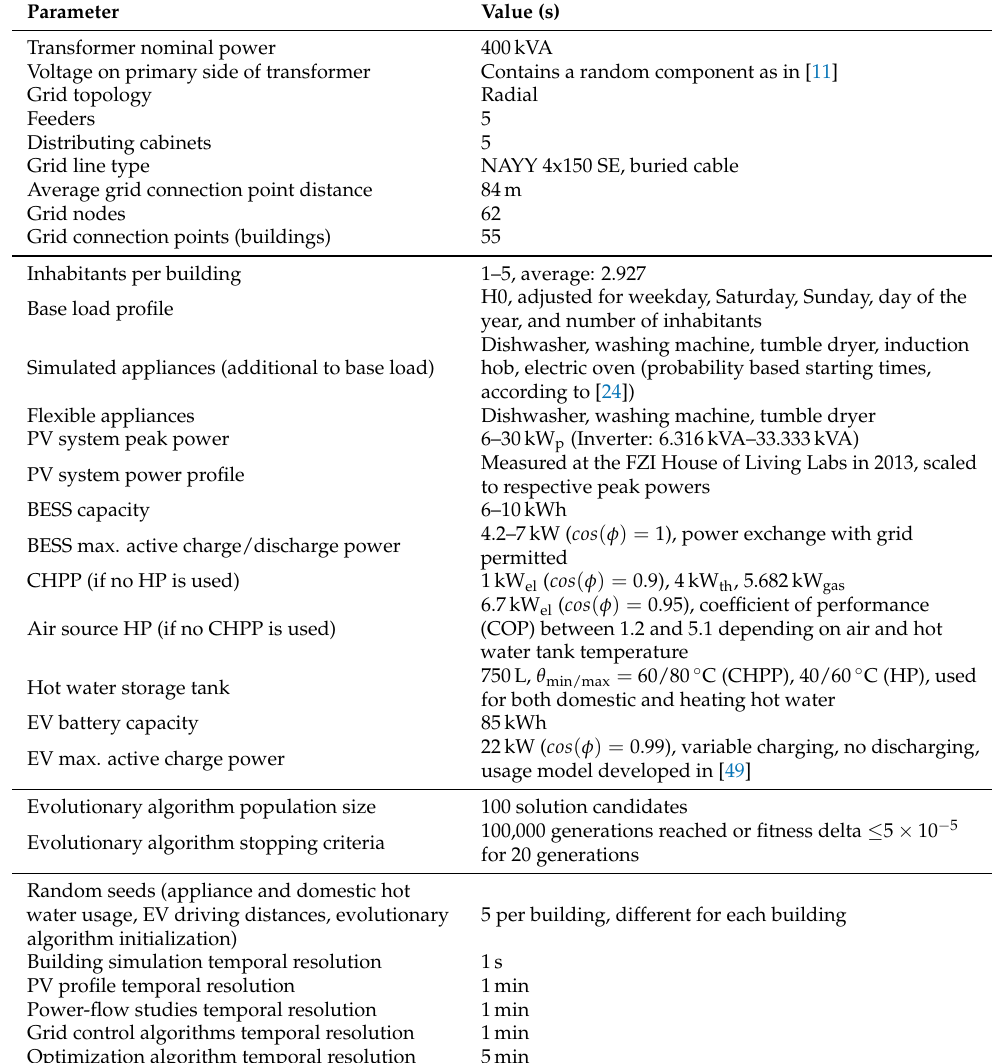
Table 4. The configuration of the simulated grid and buildings, the evolutionary algorithm, and the temporal resolutions of the simulation components. The grid configuration as well as the distributions of inhabitants, PV, heating systems, and BESSs are adopted from the village grid and the the day after tomorrow scenario utilized in [11]. The average grid connection point distance is increased from 34m to 84m, which is a top end value for villages according to the distribution given in